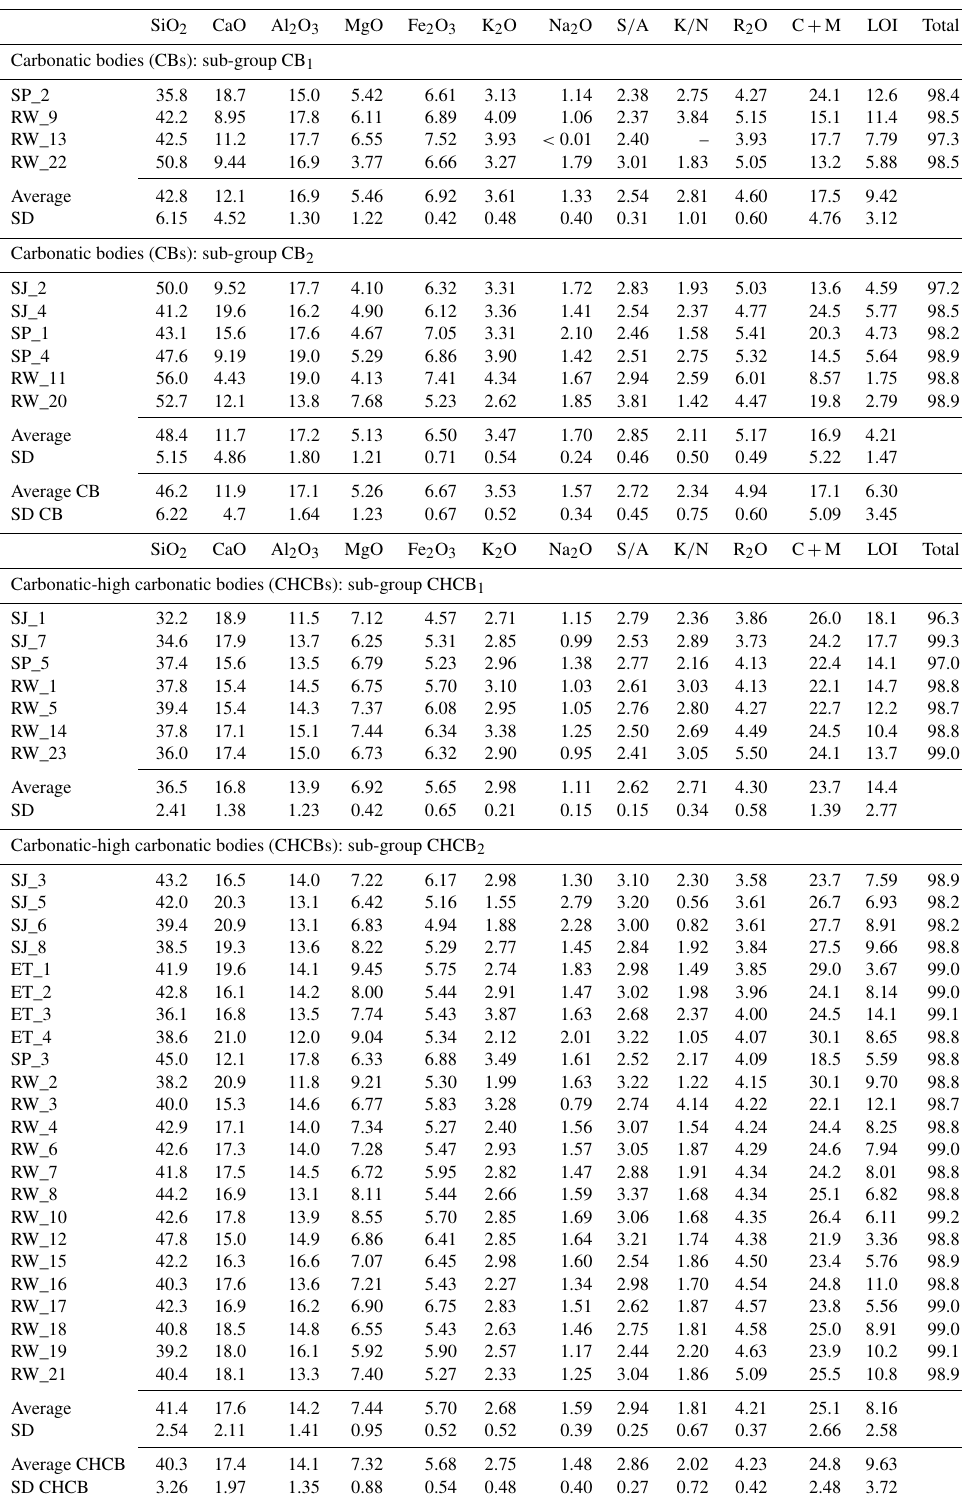
Table 3. Chemical composition of the major and minor oxides (in wt%) of CB and CHCB bricks determined by XRF. Maximum, minimum, average and standard deviation values of the samples belonging to both groups are also shown. Abbreviations: S / A, SiO 4 / Al 2 O 3 ; K / N, K 2 O / Na 2 O; R 2 O, K 2 O + Na 2 O; C + M, CaO + MgO; LOI, loss on ignition. The total amount also includes small amounts of SO 3 , TiO 2 , Cl − , P 2 O 5 and MnO oxides (wt%), which were also calculated but were not included in Table